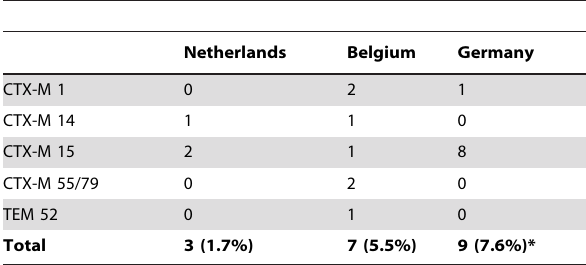
Table 2. Number and identification of ESBL producing isolates.